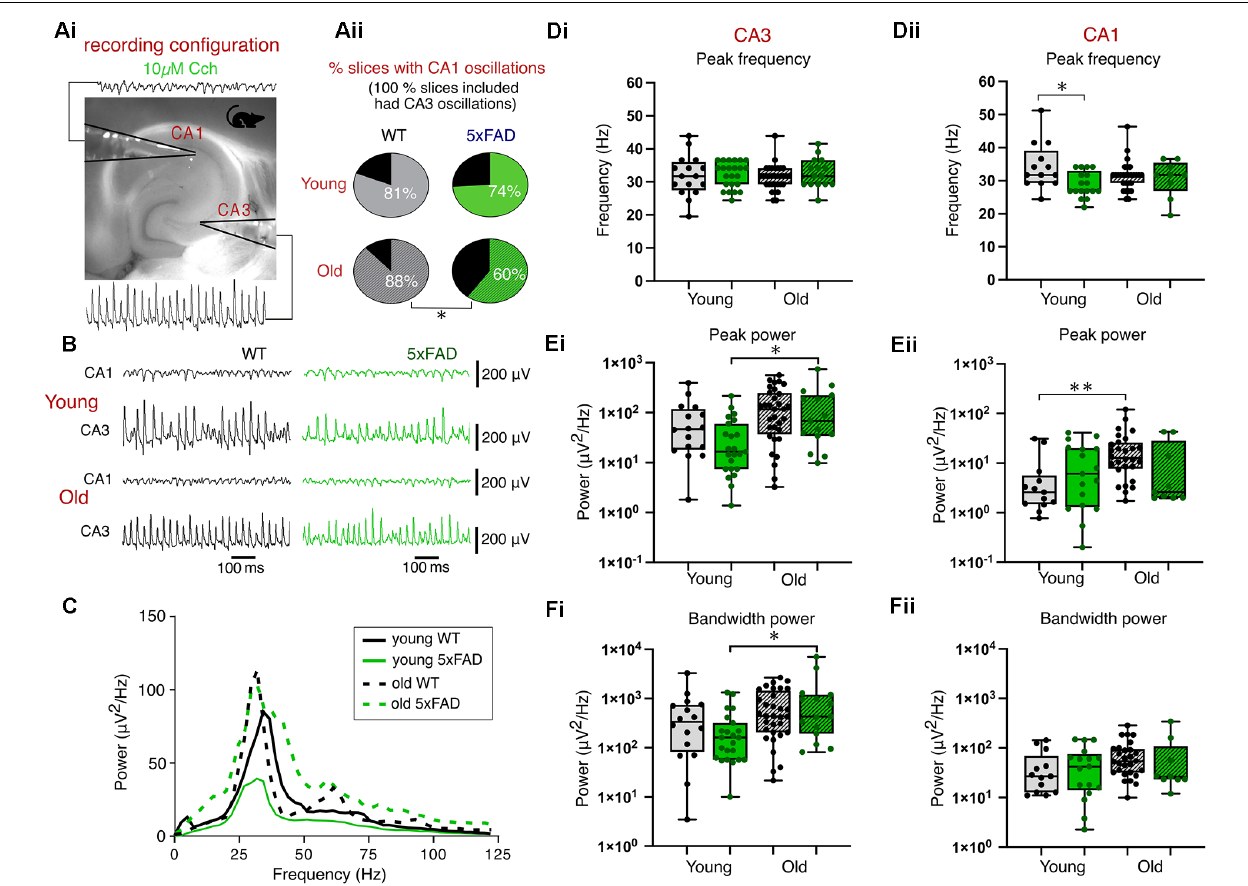
FIGURE 2 | Carbachol-induced gamma oscillations. (Ai) Experimental configuration used for recording gamma oscillations in an interface recording chamber. (Aii) Pie charts indicating the percentage of slices with coincident CA1 and CA3 gamma oscillations (all slices included in analysis exhibited CA3 oscillations). (B) Representative traces of carbachol-induced gamma oscillations. (C) Average CA3 power spectrums of young and old, control and 5xFAD slices during carbachol-induced oscillations. (D,E,F) Group data boxplots of the peak frequency, peak gamma power and bandwidth power respectively from young and old, control and 5xFAD animals in CA3 (Di,Ei,Fi) and CA1 (Dii,Eii,Fii) . Box plots show the median as the black line, the boxed region as the interquartile range, and the whiskers as the range with each data point representing a single slice. Young WT: n = 16/13 (CA3/CA1), eight mice (three females); Young 5xFAD : n = 23/17 (CA3/CA1), eight mice (four females); Old WT: n = 32/28 (CA3/CA1), six mice (one female); Old 5xFAD : n = 15/9 (CA3/CA1), five mice (two females). ∗ p < 0.05, ∗∗ p < 0.01 ( Aii : χ 2 test; D , E , F : two-way ANOVA with Sˇ idák correction for multiple